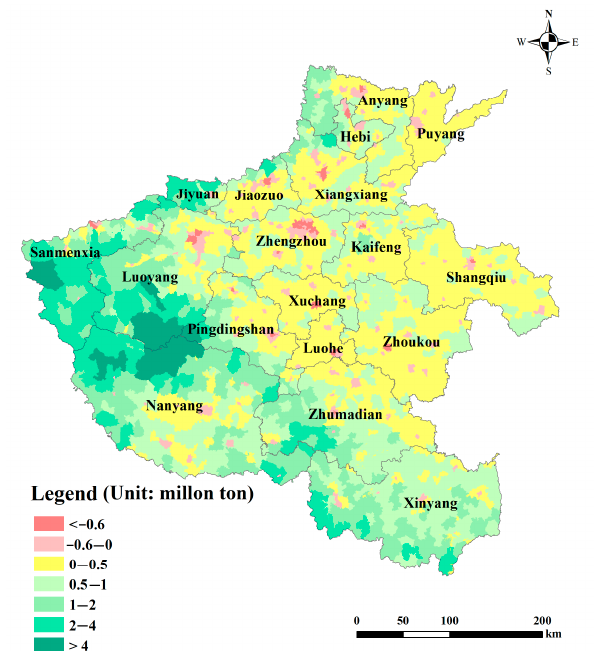
Figure 3. Spatial distribution of DSDCS.